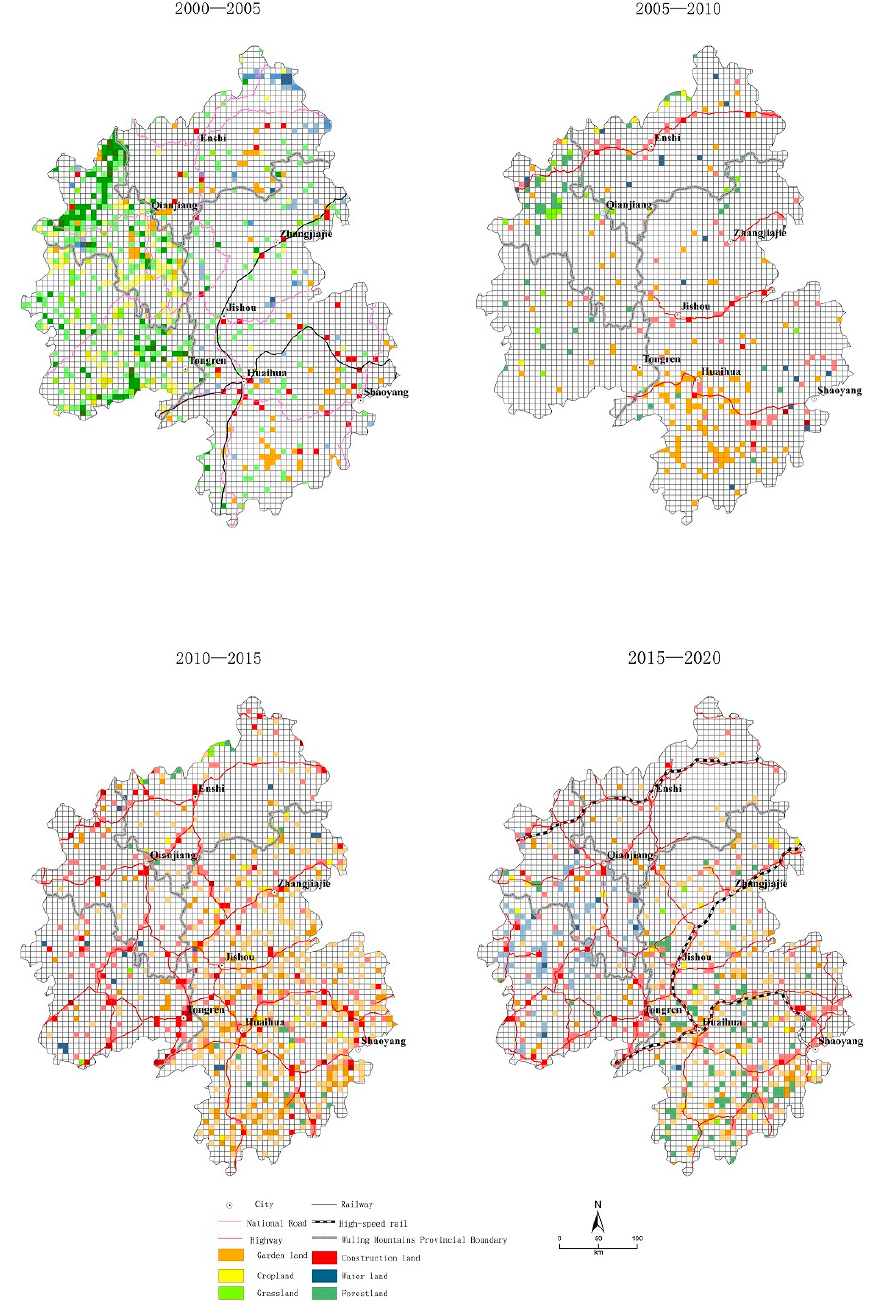
Figure 5. Spatial distribution of land-use changes from 1980–2020.